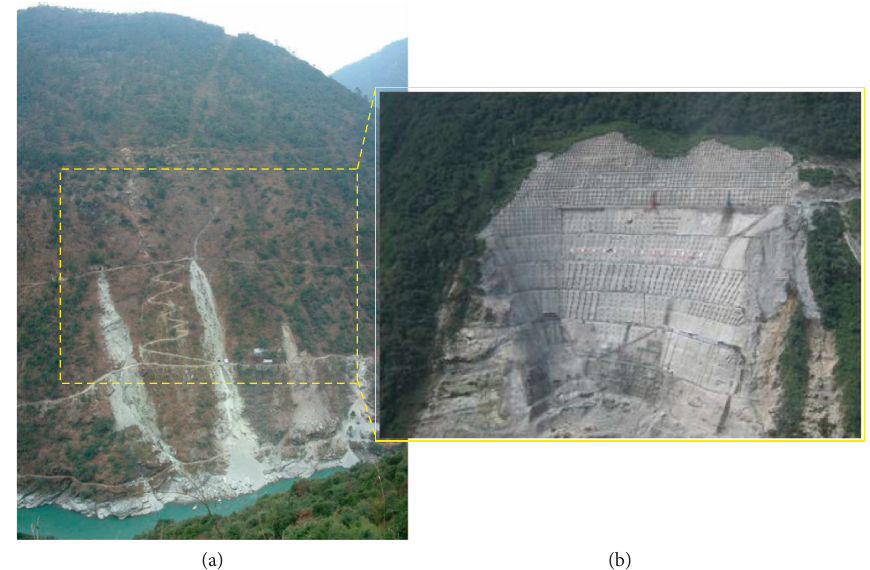
Figure 1: Geomorphic photograph of the right bank slope: (a) before excavation and (b) after